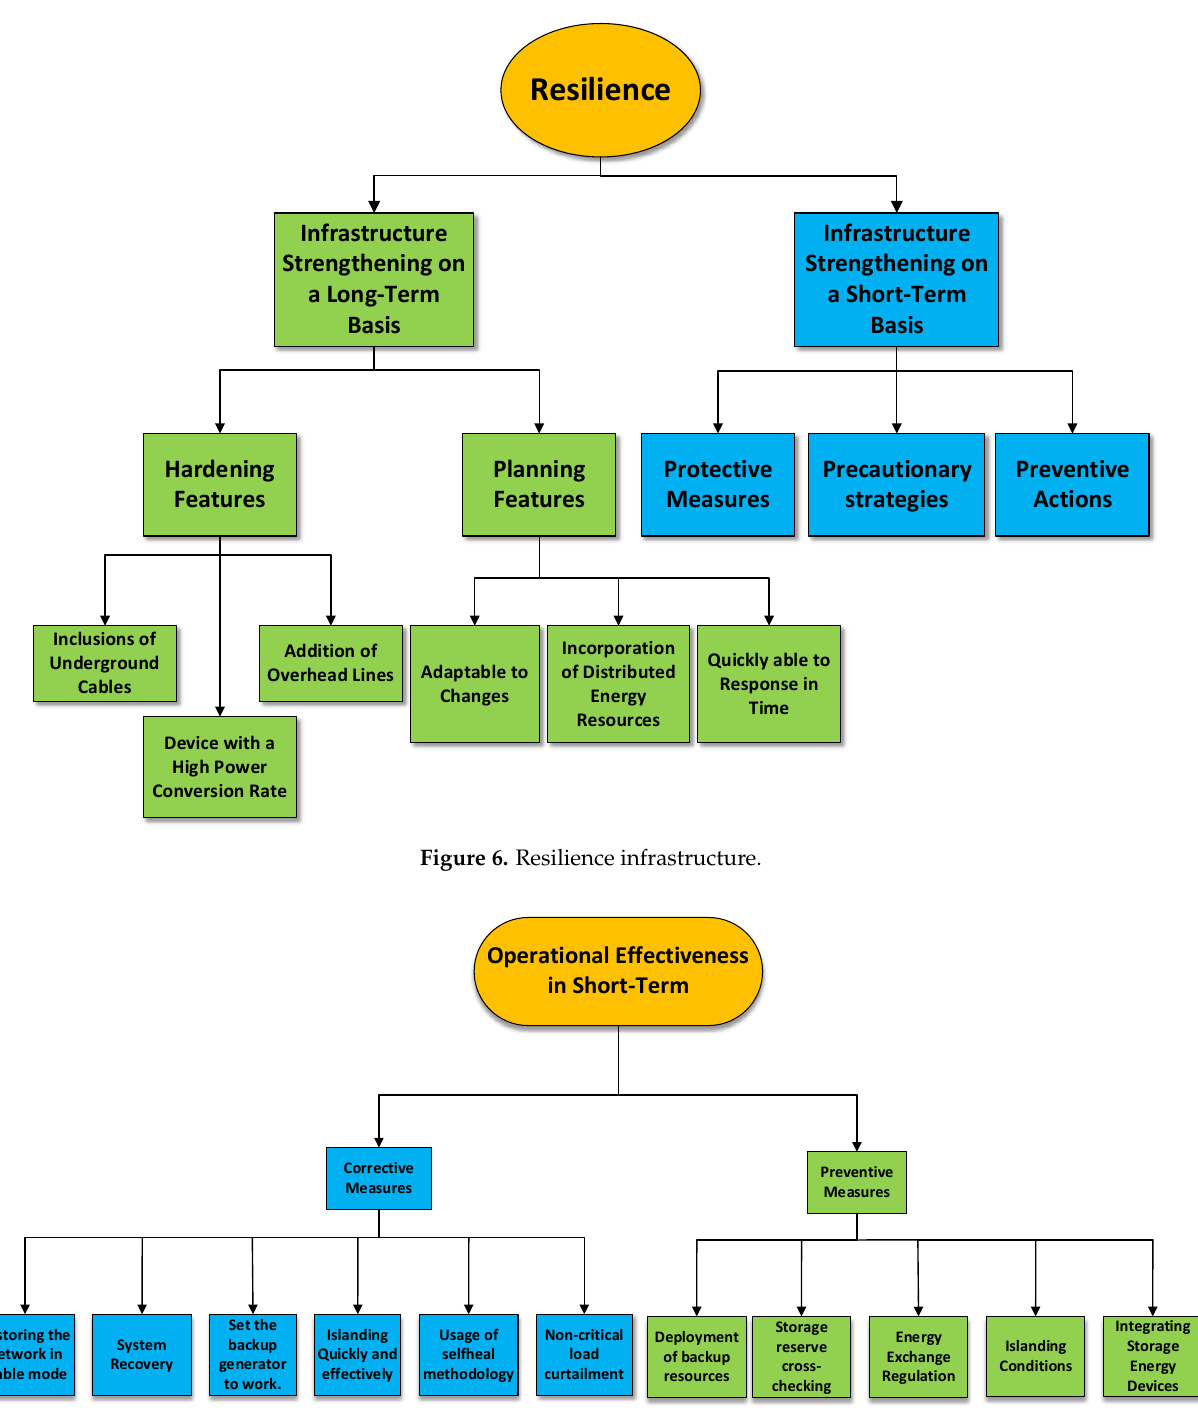
Figure 7. Short-term measures of Resilience.